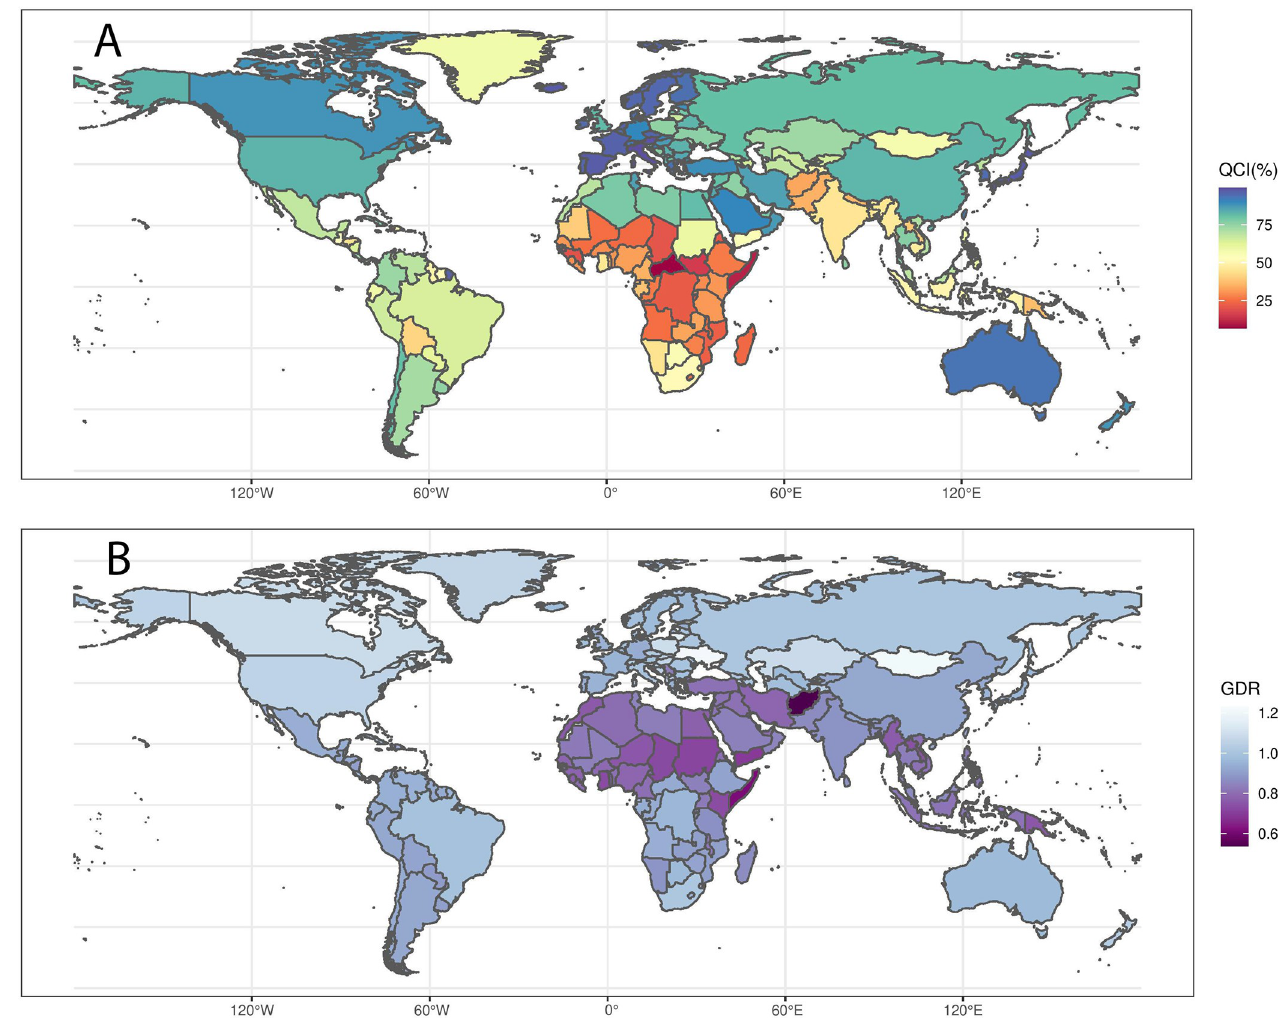
The region of the Americas was the only region with a GDR above 1 (1.02). European region and Western Pacific region followed it with GDR values of 0.97 and 0.93. Eastern Medi- terranean region (0.75), the African region (0.75), and the South-East Asia region (0.83) had higher rates of gender disparity. While the South-East Asia region (GDR change: 0.11), West- ern Pacific region (GDR change: 0.10), and Eastern Mediterranean region (GDR change: 0.06) ameliorated their GDR by more than 0.05 since 1990, the African region showed no progress (GDR change: 0.00) ( Table 2